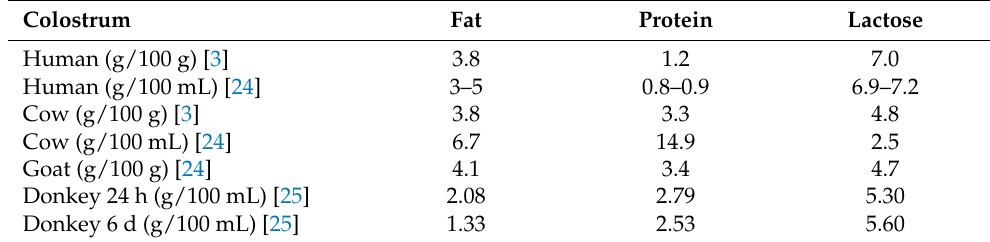
Table 1. Chemical composition in colostrum from different mammalian species. Colostrum Fat